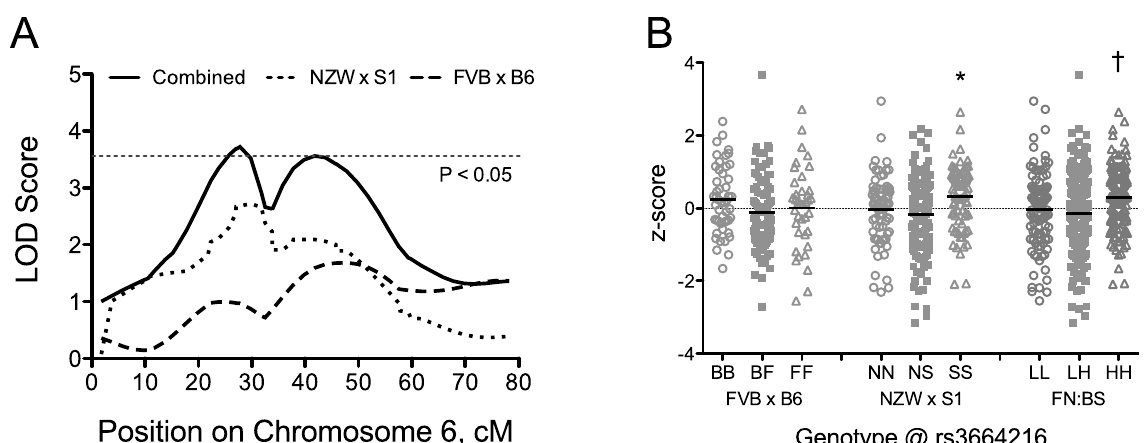
Fig 5. LOD score plots (A) and allele effect plots (B) for QTL for change in exercise time on Chromosome 6 using combined cross analysis. LOD score plots are shown for FVB x B6 F 2 (dashed line), NZW x 129S1 F 2 (dotted line) and combined cross (sold line). Horizontal dashed line represents significant (P = 0.05) LOD threshold for the combined cross. For allele effect plots, the y-axis is the z-score transformed change in exercise time and the x- axis indicates cross-specific genotypes. Homozygous S1, NZW, FVB, and B6 are denoted “ SS ” , “ NN ” , “ FF ” , and “ BB ” , respectively. Heterozygous alleles are denoted “ NS ” and “ BF ” in individual crosses. For combined cross analysis, genotypes were re-coded as “ HH ” for high performing strains (B6, 129S1) and “ LL ” for low performing strains (FVB, NZW), and “ LH ” for heterozygotes. Allele effects are shown at the peak location for the QTL. The solid black line for each genotype represents the mean. * , P < 0.05 compared with alternate homozygous “ NN ” genotype; † , P < 0.05 compared with other genotypes.